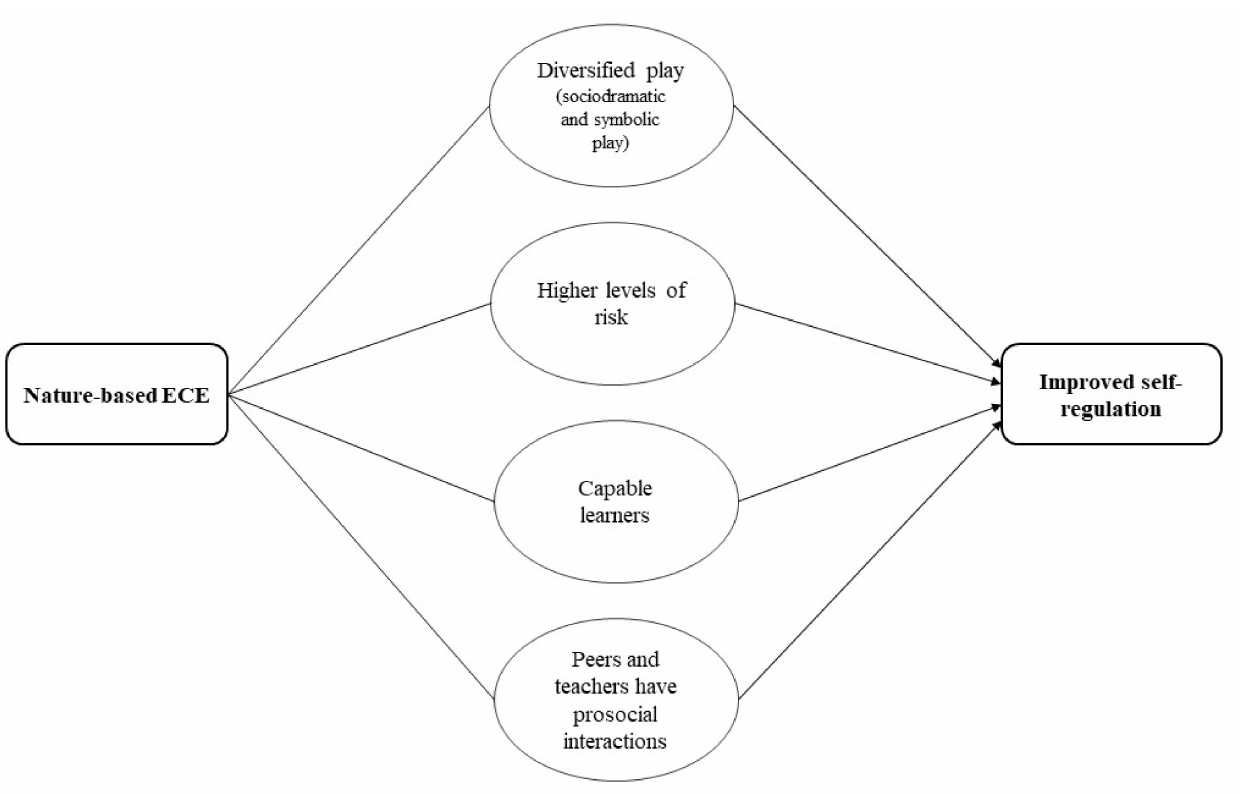
Figure 9. Convergent synthesis on how nature-based ECE could influence self-regulation. An arrow denotes where factors influence